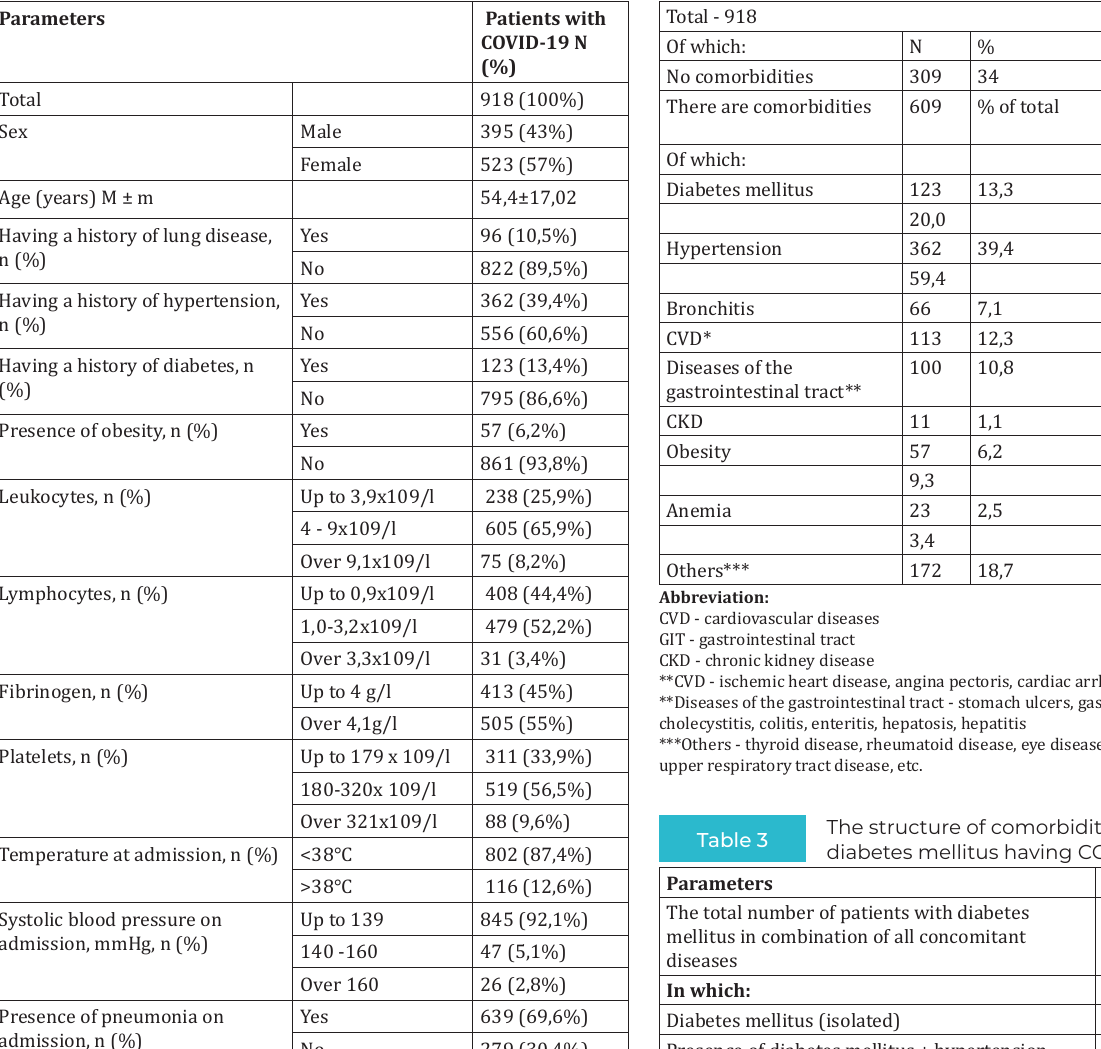
The structure of comorbidities in patients hospitalized with COVID-19